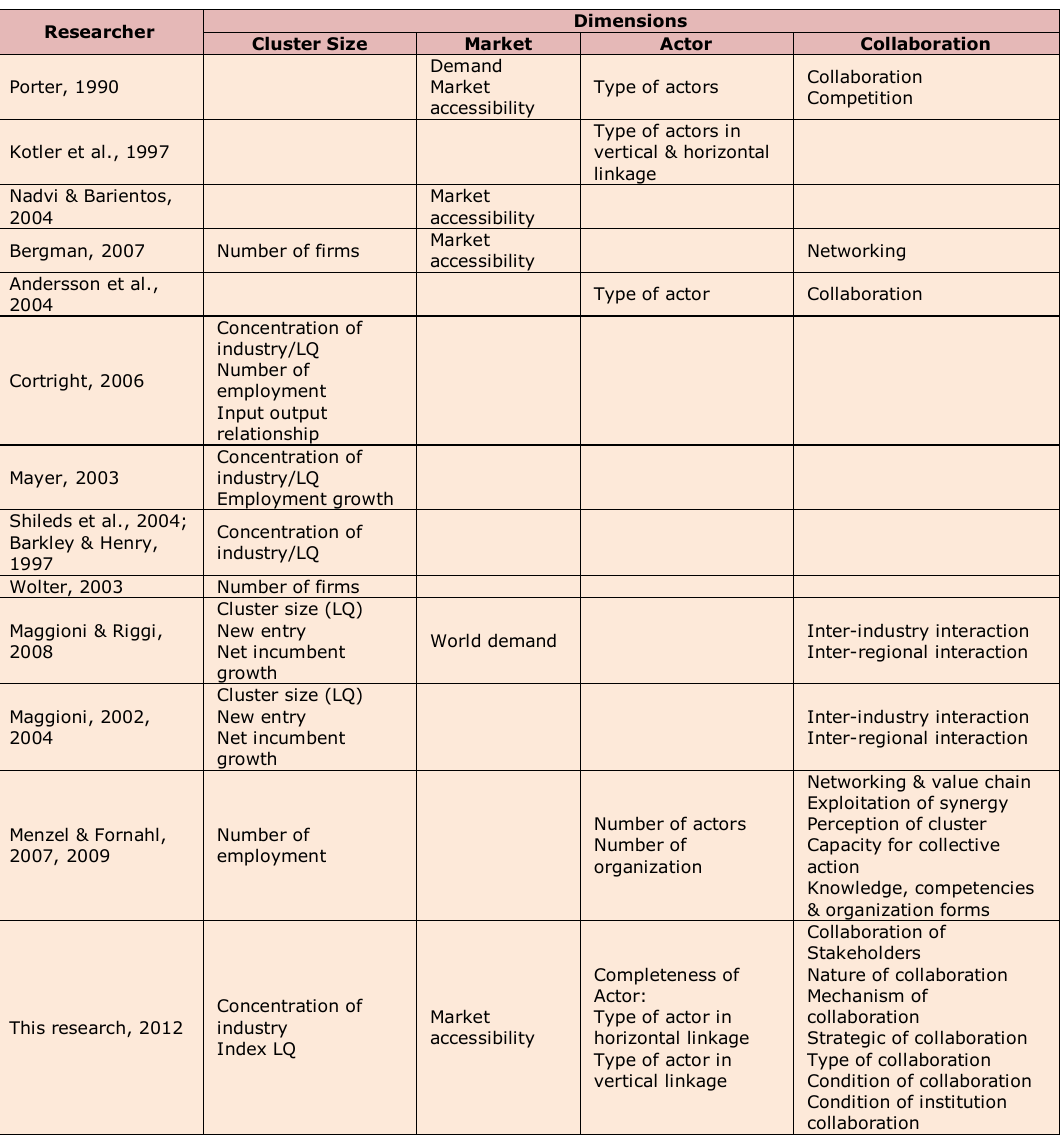
Table 2. State of the art the assessment dimensions to identify phase of industrial cluster life